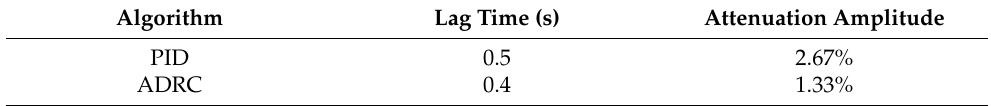
Table 3. Time domain index under sinusoidal